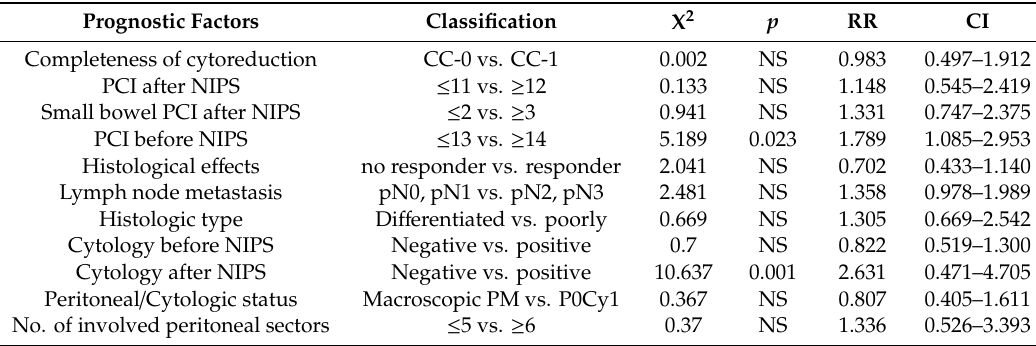
Table 2. Independent prognostic factors.